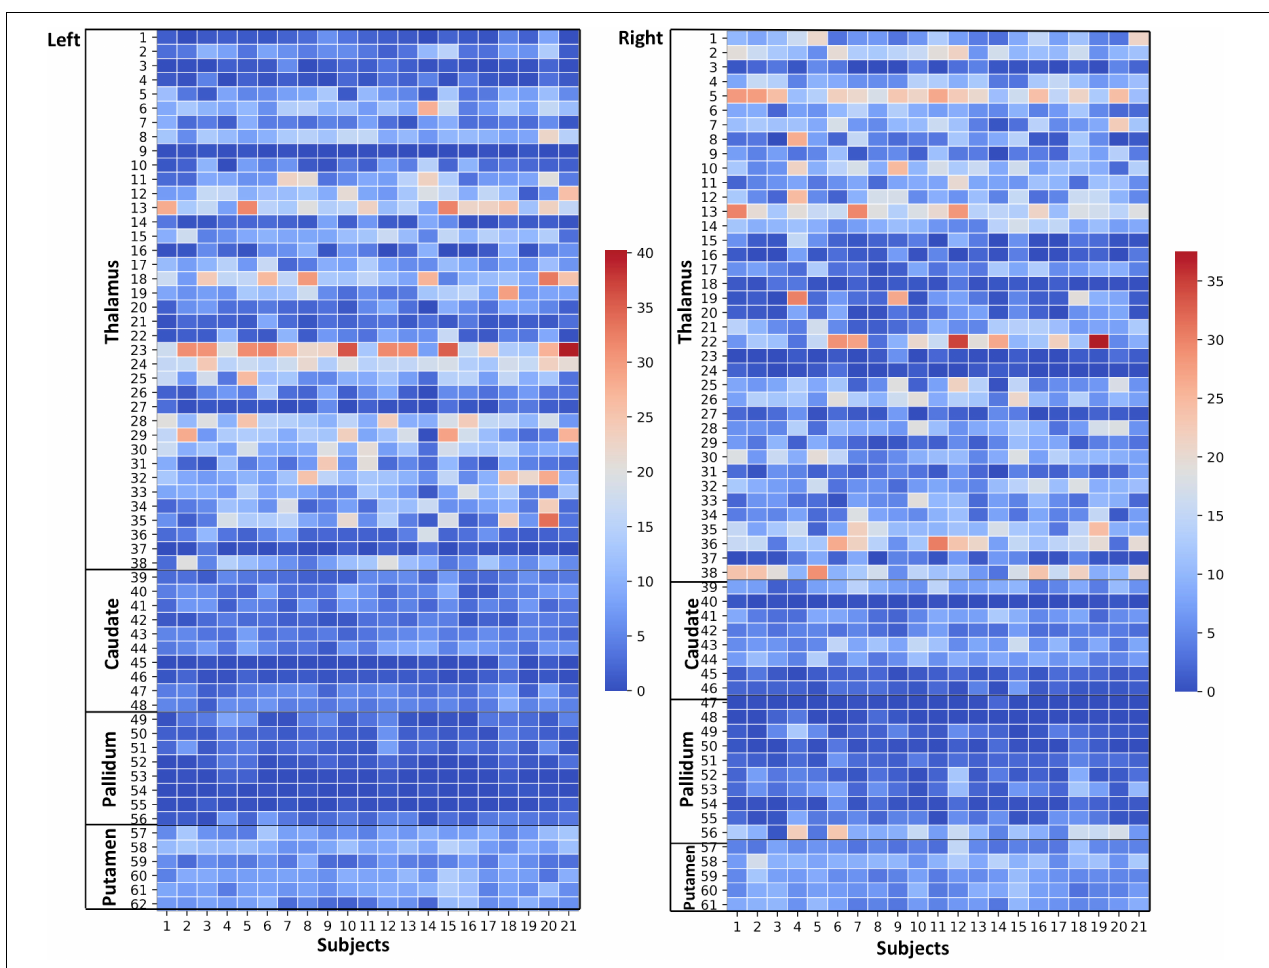
FIGURE 4 | Thalamus and Basal Ganglia (Diamagnetic sources, i.e., Myelin, Calcium, etc.): Left hemisphere: Mean diamagnetic source values for all parcels in all subjects in the left hemisphere. Each column represents each subject. Each row represents a functional parcel. The total number of functional parcels is 62, i.e., Thalamus (38) + Caudate (10) + Pallidum (8) + Putamen. (6) Right hemisphere: Mean diamagnetic source values for all parcels in all subjects in the right hemisphere. The total number of ICP functional parcels is 61 i.e., Thalamus (38) + Caudate (8) + Pallidum (10) + Putamen (5). Note the higher values in some thalamus parcels compared to other